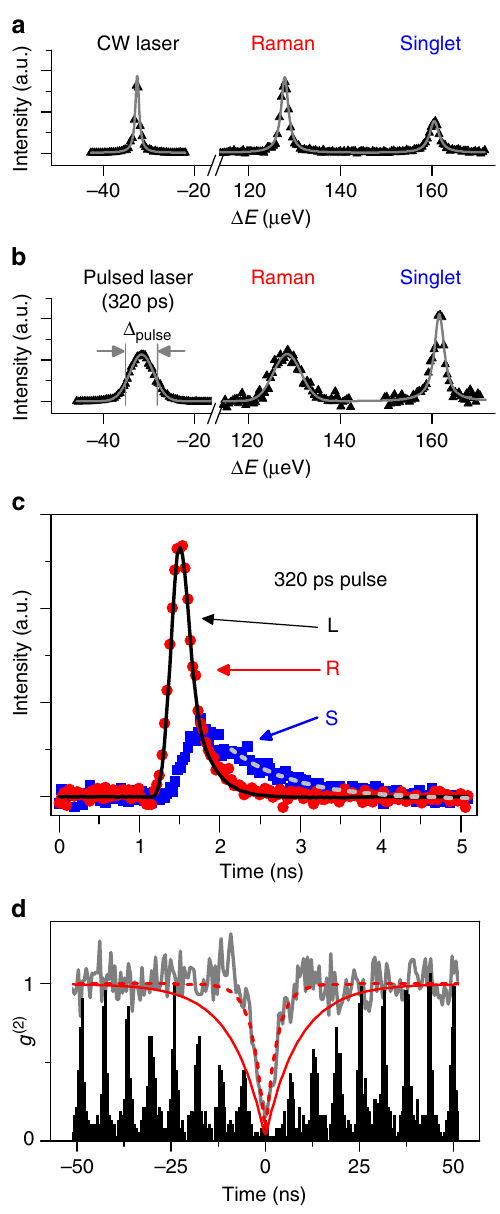
Fig. 3 Pulse-shaping spin- fl ip Raman. a , b Spectrum of the laser, Raman emission, and singlet PL for a the cw laser and b a 320-ps pulsed laser, with δ = − 35 µ eV. c Temporal pro fi le of the laser (L), the Raman (R), and the singlet (S) emission with δ = − 50 µ eV. d The second-order correlation function for pulsed (black line) and cw (gray line) excitation under similar conditions with fi ts (solid and dashed red lines, respectively). For cw excitation, the rise time was 3 ns; for pulsed, the rise time was 9 ns